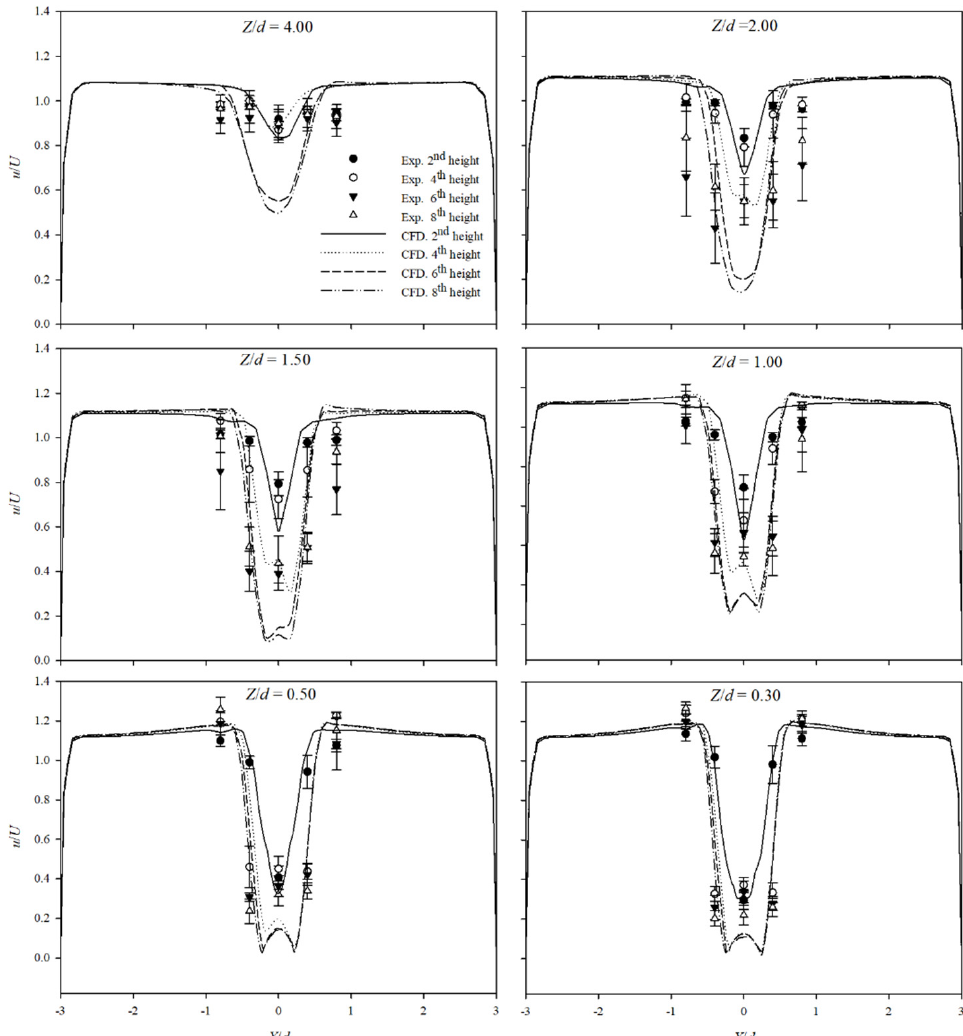
Figure 5. Profiles of normalized velocities at different Z/d locations.